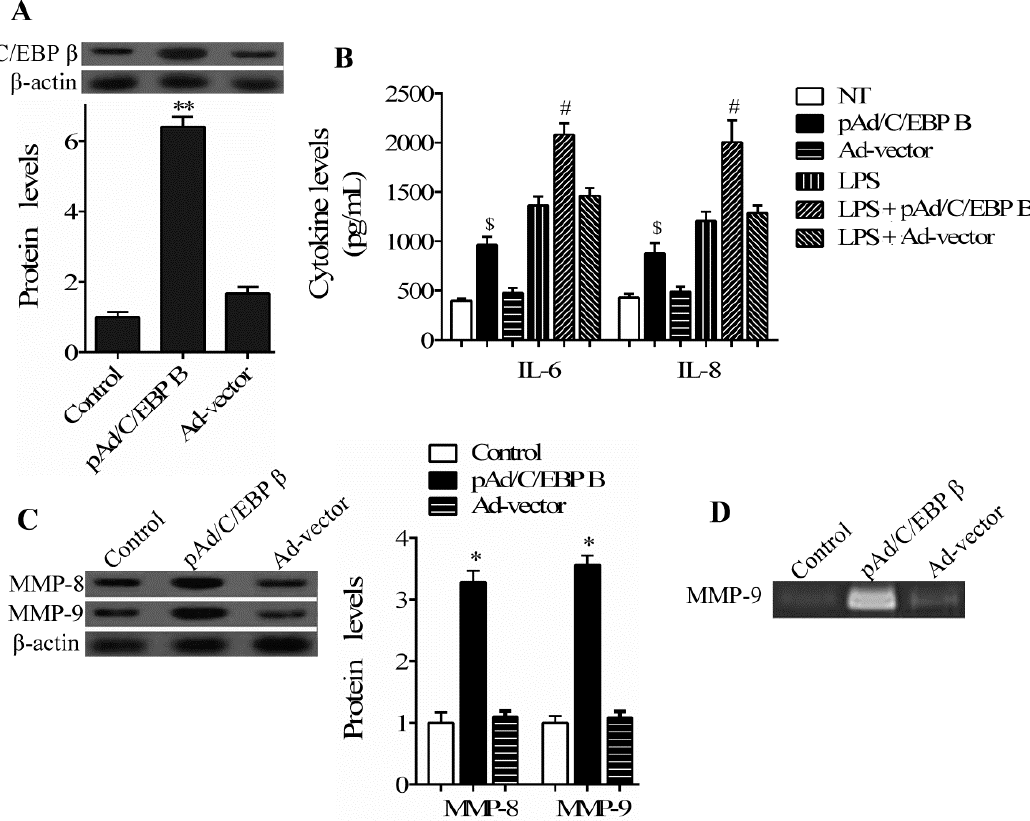
Figure 2. Effect of C/EBP β on production of pro-inflammatory cytokines and activation of matrix metalloproteinases (MMPs) in hPDLCs exposed to LPS. hPDLCs were transfected with a recombinant adenoviral vector pAd/C/EBP β or Ad-GFP control vector for 48 h, followed by stimulation with P. gingivalis LPS for another 24 h. ( A ) The protein level of C/EBP β in hPDLCs was determined by Western blotting; ( B ) The levels of IL-6 and IL-8 were analyzed by ELISA assay in hPDLCs transfected with adenoviral vector pAd/C/EBP β or Ad-vector in the presence or absence of LPS; ( C ) MMP-8 and MMP-9 levels in hPDLCs stimulated with LPS were analyzed by Western blotting assay; ( D ) gelatin zymography was performed to determine MMP-9 activity in hPDLCs stimulated with LPS. Untransfected hPDLCs were stimulated by P. gingivalis LPS and used as the control in ( A , C , D ). ($ p < 0.05 vs. NT; # p < 0.05 vs. LPS; * p < 0.05, ** p < 0.05 vs. control).